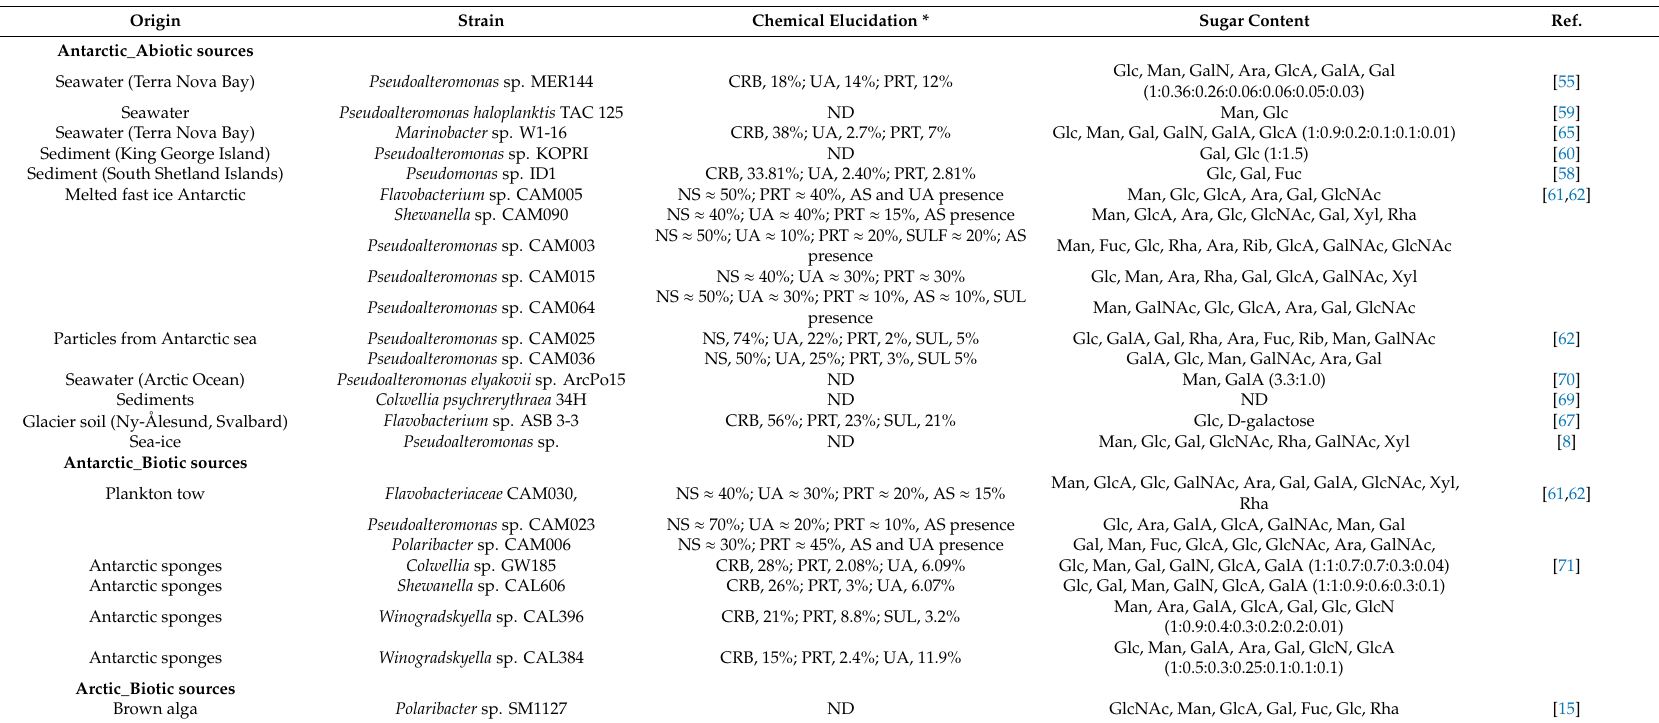
Table 2. List of cold adapted extracellular polymeric substances (EPS) bacterial producers considered for the review